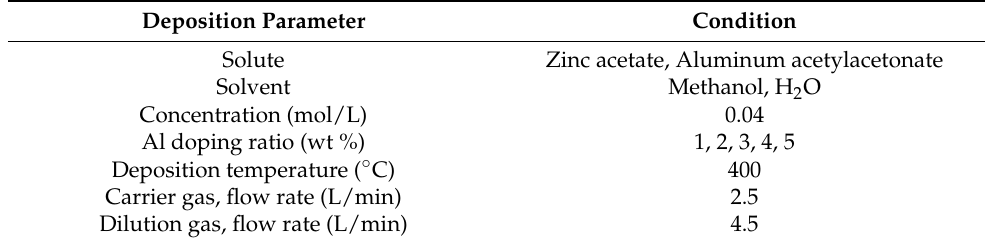
Table 1. Deposition conditions of AZO films by the mist CVD method. Deposition